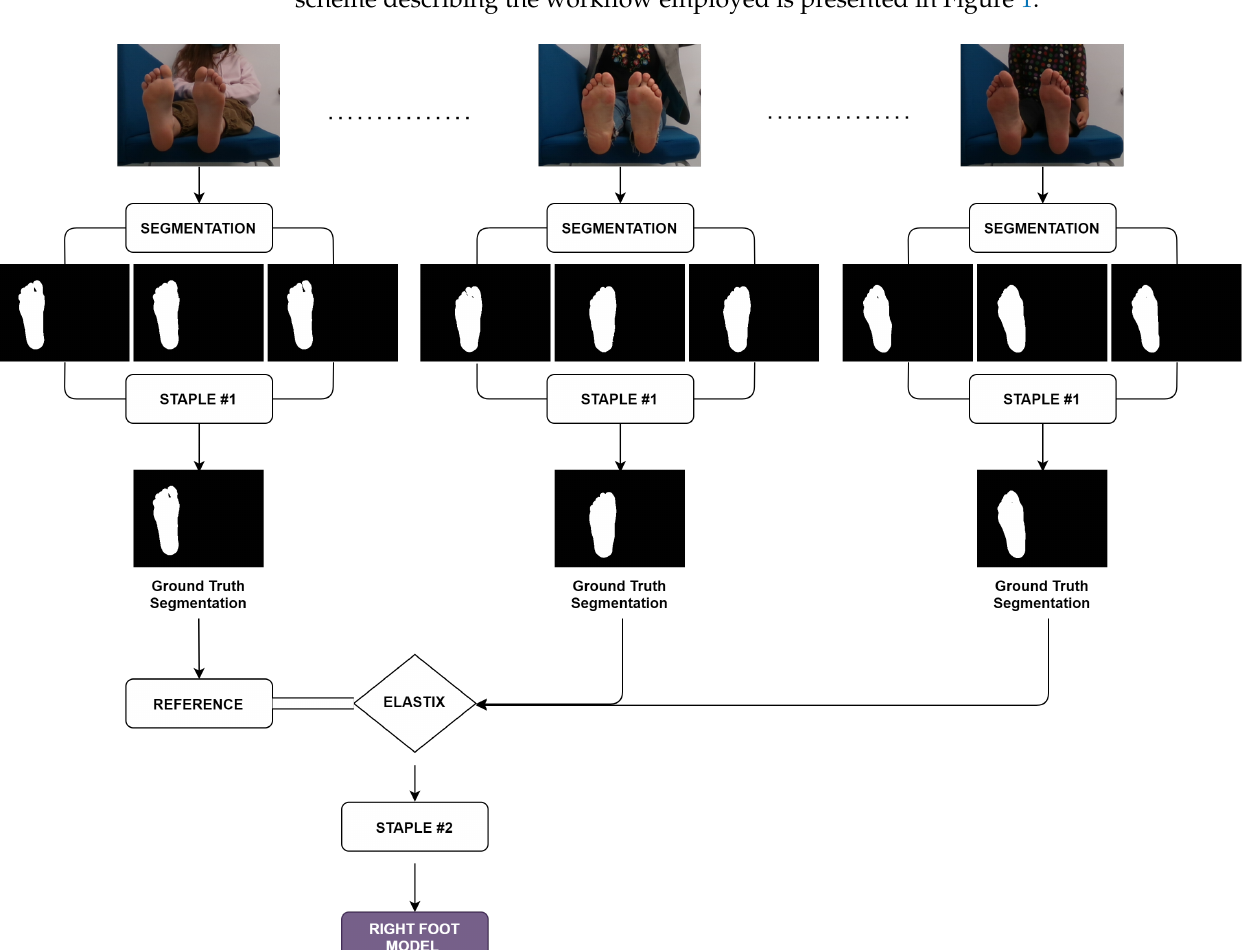
Figure 1. Workflow employed to extract the right foot model. This process is repeated using all subjects as reference to extract the final model. A similar workflow is employed for the left